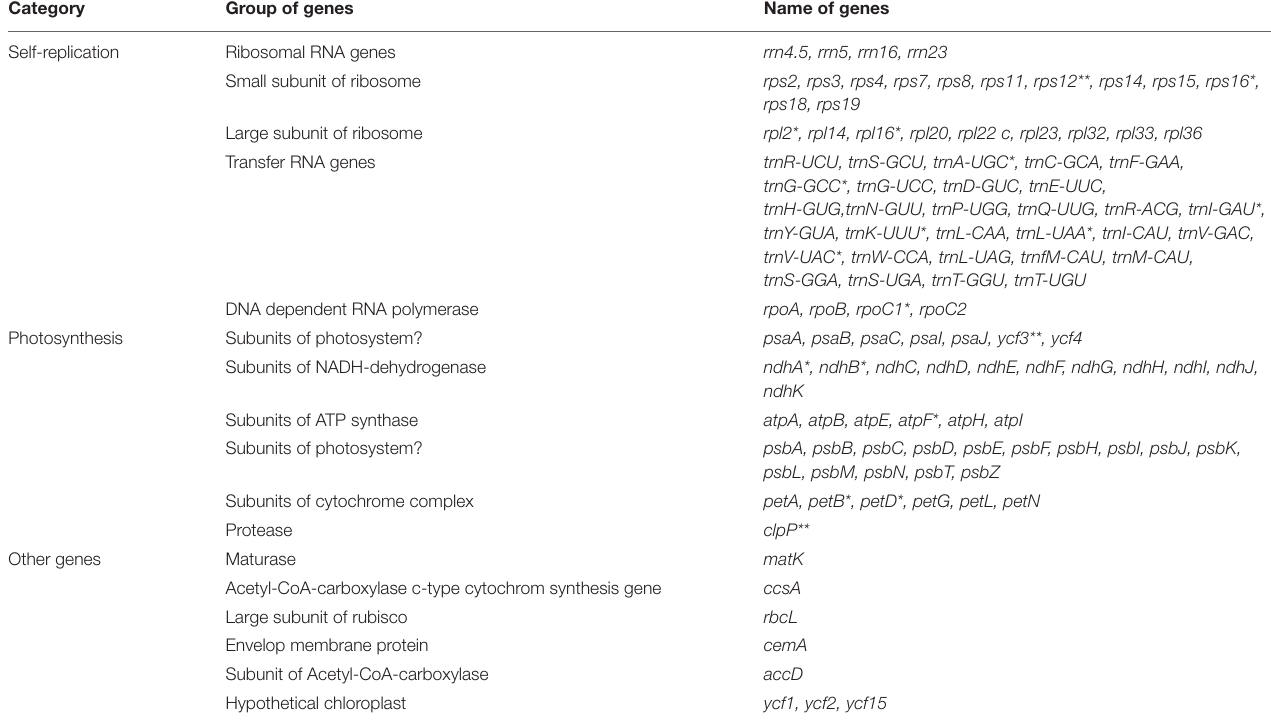
TABLE 3 | Genes contained in the cultivated and wild rubber tree chloroplast genomes. Category Group of